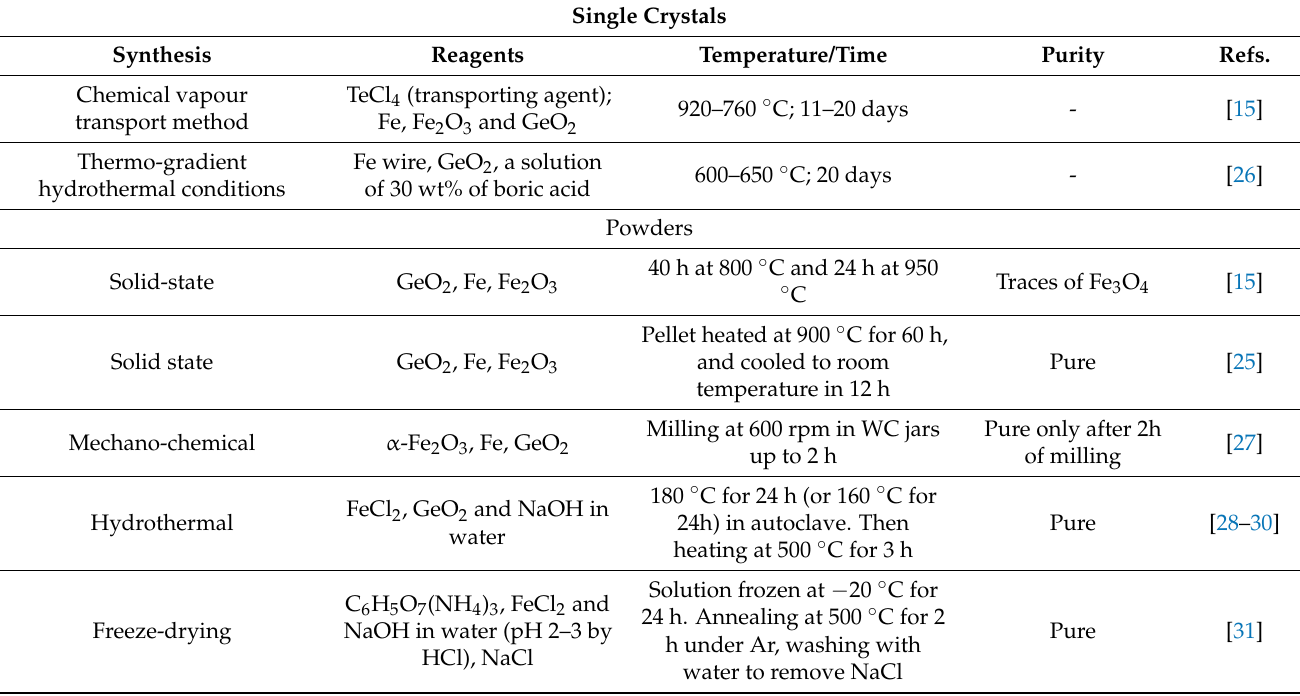
Table 1. The main synthesis methods of GFO reported up to now in the literature and described in the text.